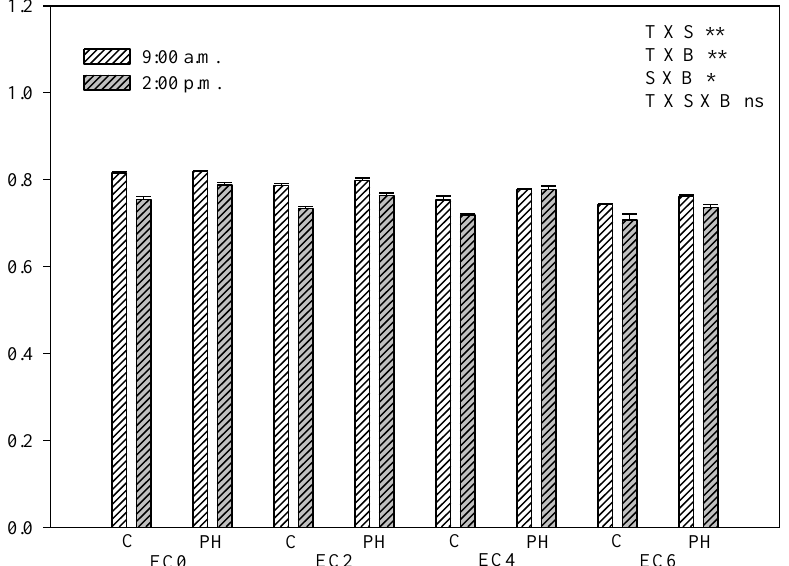
Figure 5. Fv/Fm of hemp leaves in the DAS as affected by saline water irrigation (EC0 = non-saline water; EC2 = water at 2.0 dS m −1 ; EC4 = water at 4.0 dS m −1 ; EC6 = water at 6.0 dS m −1 ) and biostim- ulant application (treated with a commercial legume-derived protein hydrolysate = PH and non- treated = C) recorded at 9:00 a.m. and at 2:00 p.m. Bars are means ± s.e. ( n = 10). The significance of the interactions between experimental factors (T time of measurement, S salinity level, B biostimu- lant application) according to Duncan’s test is reported (* p ≤ 0.05, ** p ≤ 0.01, ns non-significant); pairwise comparisons with the Student’s t-test are reported in Table S1.